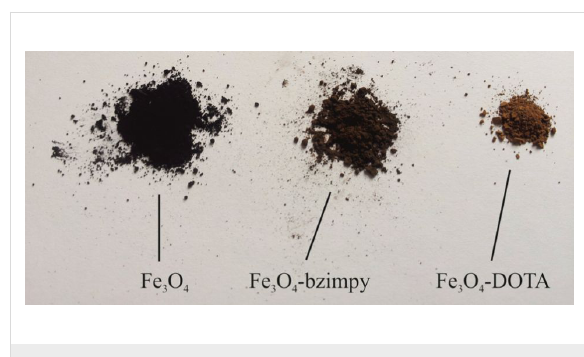
Figure 5: MNP after different functionalisation steps.